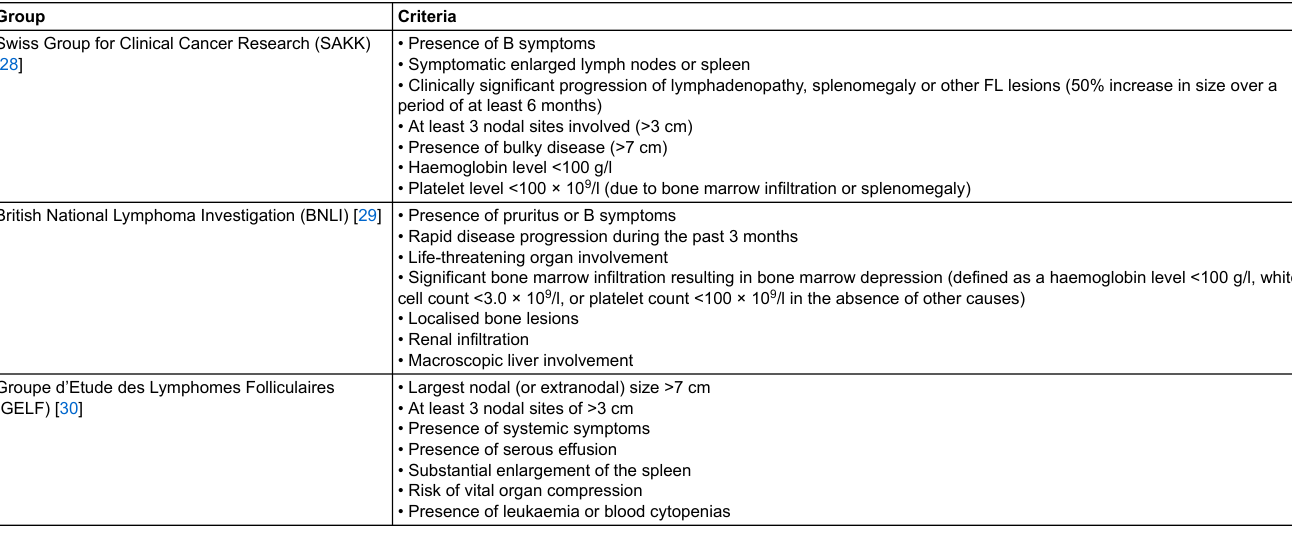
Table 2: Comparison of criteria for starting treatment in follicular lymphoma patients.